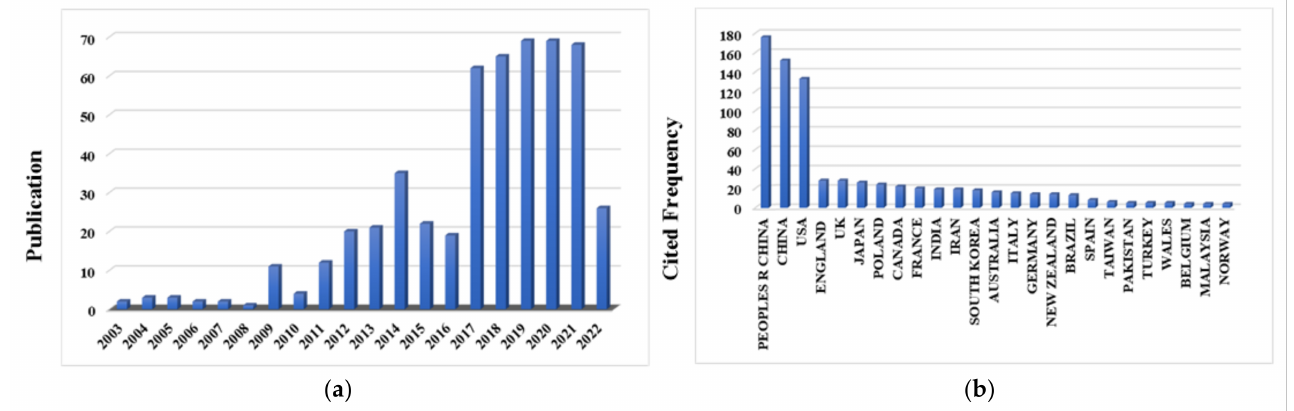
Figure 1. Search results by Web of Science. ( a ) Distribution by time; ( b ) Distribution by